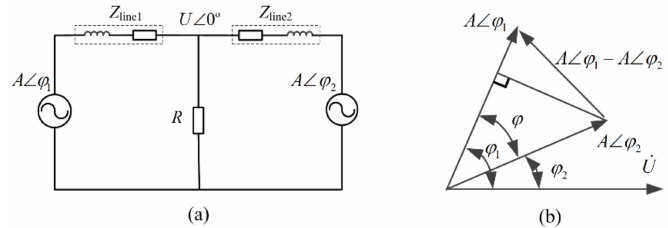
Figure 3. AC model and phasor diagram of two parallel converters: ( a ) AC model; ( b ) phasor diagram.